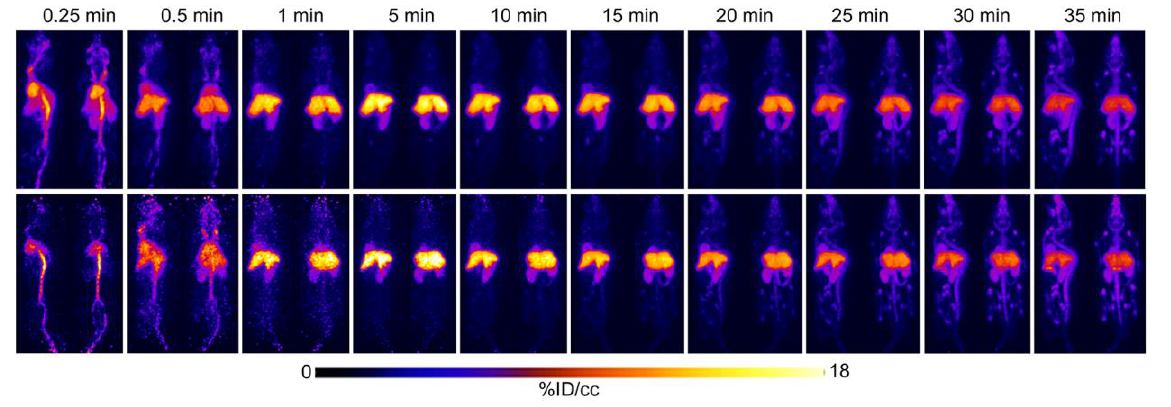
Figure 1. Comparative PET images of 15–18-week-old, fasted WT vs. Ceacam1 − / − mice administered [ 18 F]FTO followed by a 35 min dynamic scan. Top panel: male WT mouse injected with 6.7 MBq of [ 18 F]FTO. Bottom panel: male Ceacam1 − / − mouse injected with 2.7 MBq of [ 18 F]FTO. Selected time points are shown from a representative animal ( n = 4 per group).